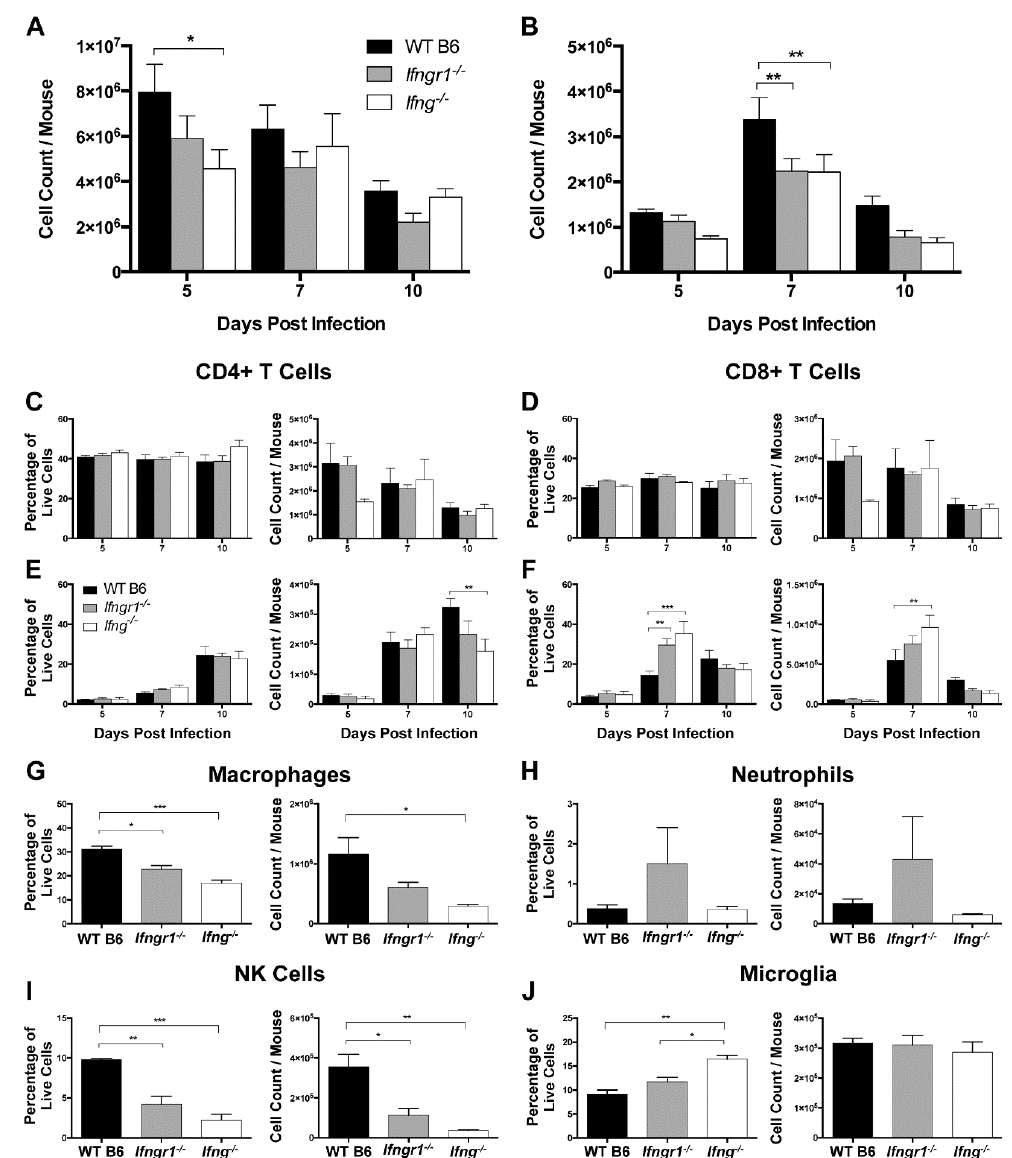
+ (Figure 7C) or CD8 T cells (Figure 7D) in CLNs were a ff ected by impaired IFN- γ signaling, with a general overall decrease from 5 DPI to 10 DPI. Viruses 2019 , 11 , x FOR PEER REVIEW